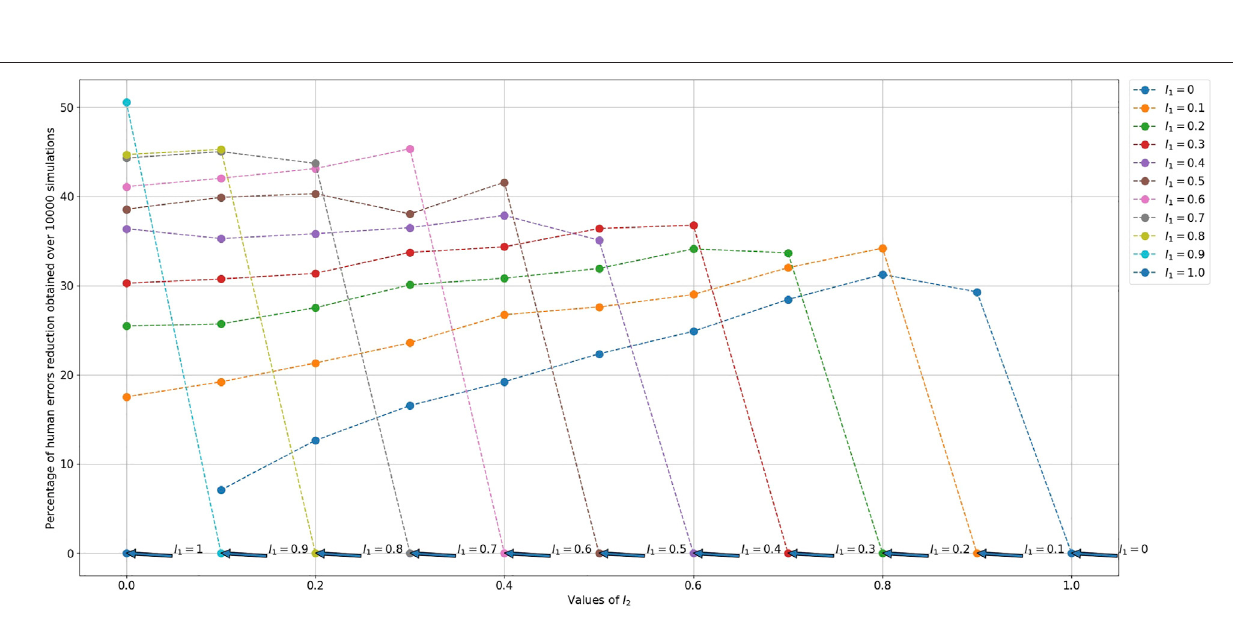
(cid:2) { 15 , 0 , 15 } h 1 value. Each